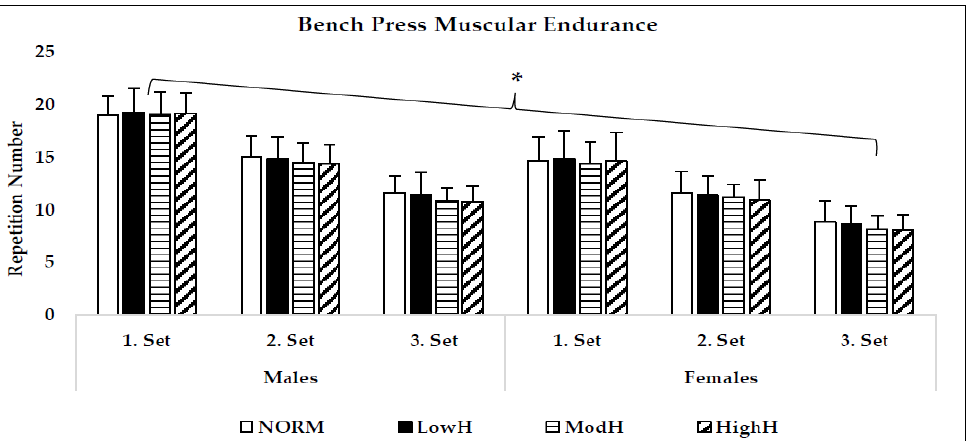
Figure 4. Mean (SD) bench press 60% of 1RM endurance performance of males and females. NORM: Normoxia (900 m); LowH: Low dose of hypoxia (2000 m); ModH: moderate dose of hypoxia (3000 m); HighH: high dose of hypoxia (4000 m). * ModH and HighH were significantly different than NORM and LowH.